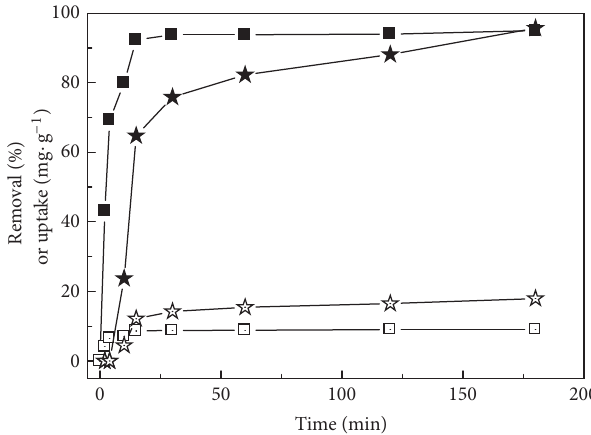
F 3: Effect of contact time on the sorption of Cd(II) on the functionalized resin from aqueous Cd(II) solutions at two different concentrations ( F 4: Plots for the adsorption of Cd(II), m = 0.030g, V = 5mL, and initial pH = 5.0.